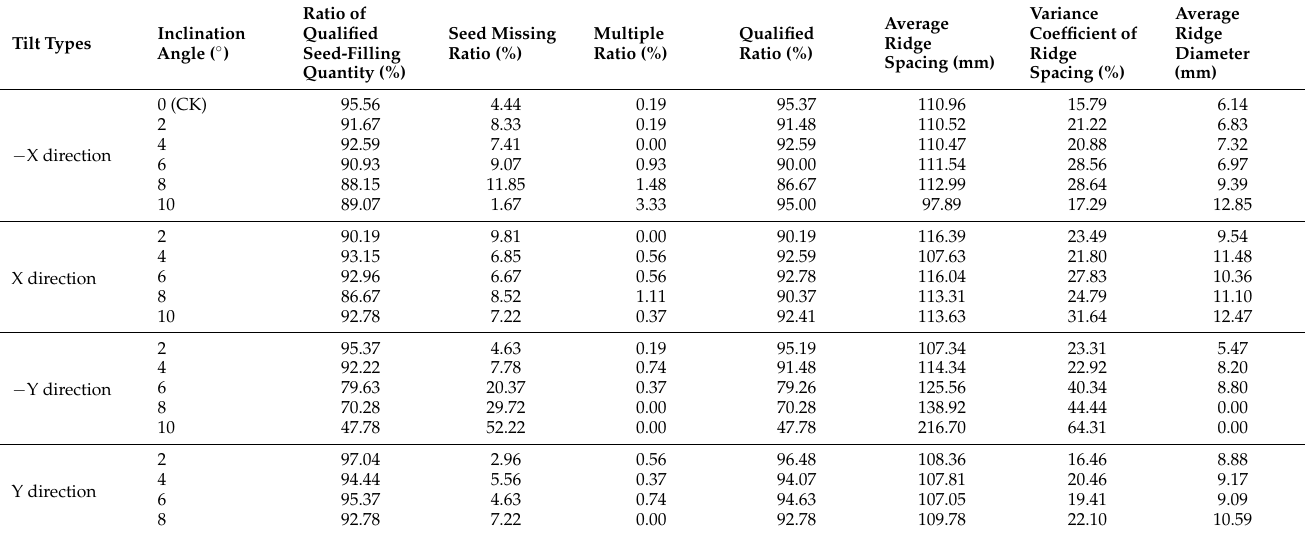
Table 3. Effects of inclination angle on seeding performance in bench